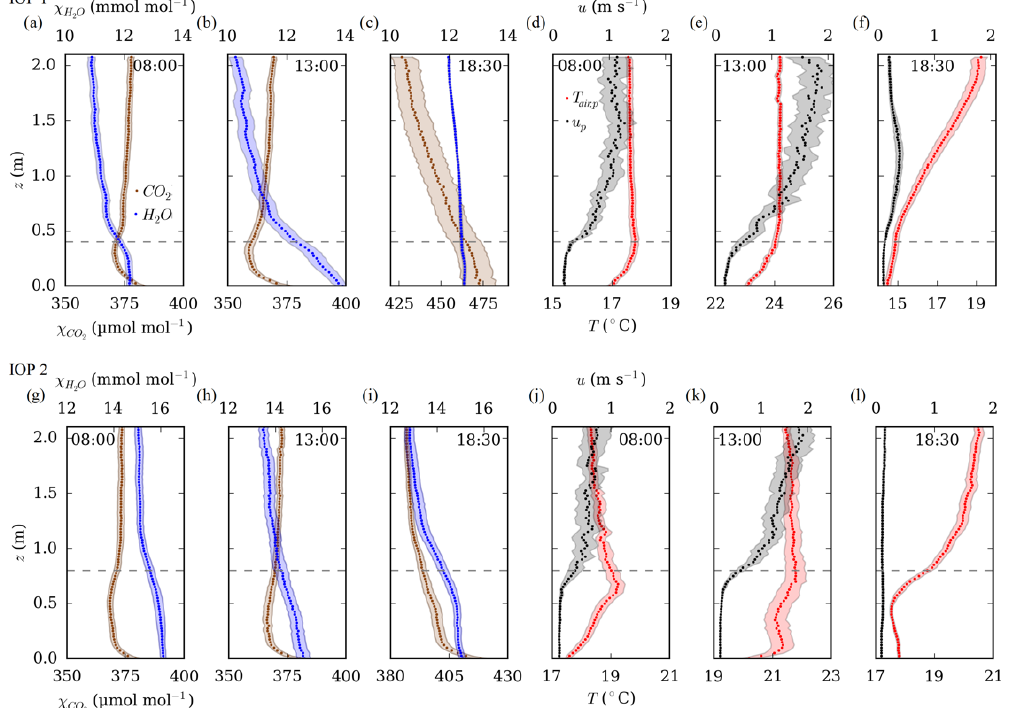
Figure 7. Selected (08:00, 13:00 and 18:30UTC) 30min mean profiles of the H 2 O and CO 2 mole fractions ( χ H 2 O, χ CO 2 ), wind speed ( u p ), and temperature ( T air , p ) measured at high vertical resolution during IOP 1 (upper row) and IOP 2 (lower row). Shaded areas indicate the 95% confidence interval resulting from the standard deviation between individual profiles sampled within a 30min average interval. The dashed lines indicate the canopy